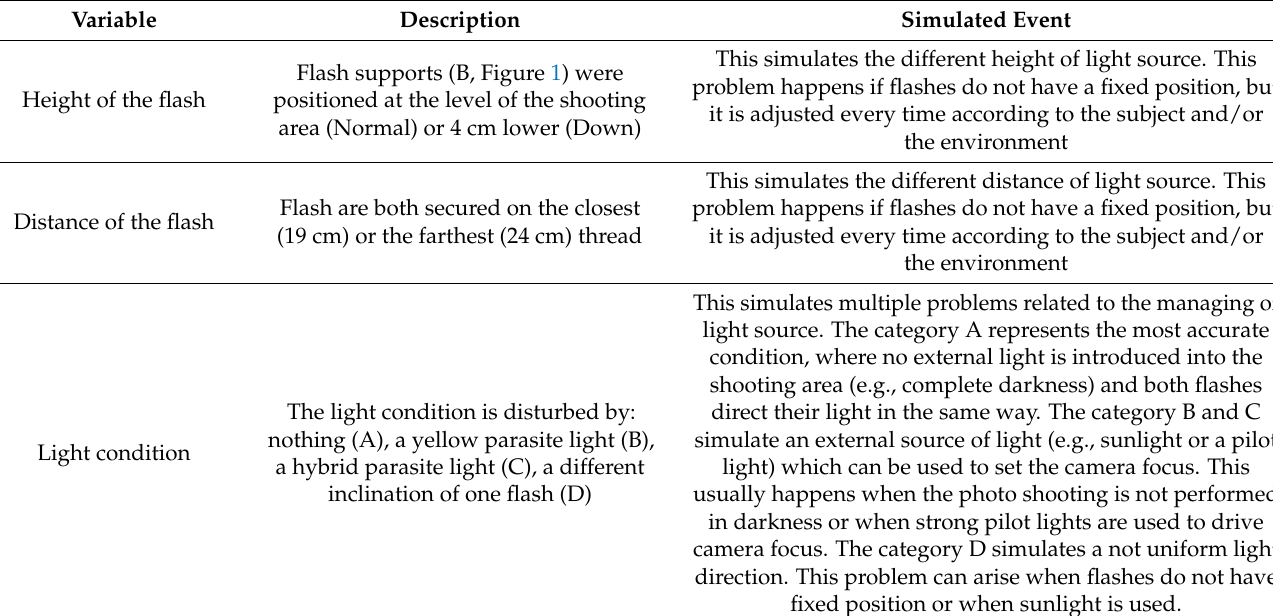
Table 2. The disturbing events simulated in the study and their potential implications on the image quality. Each variable used in the analysis is described, also providing information on the hypothetical problems that it simulates. Variable Description Simulated Event